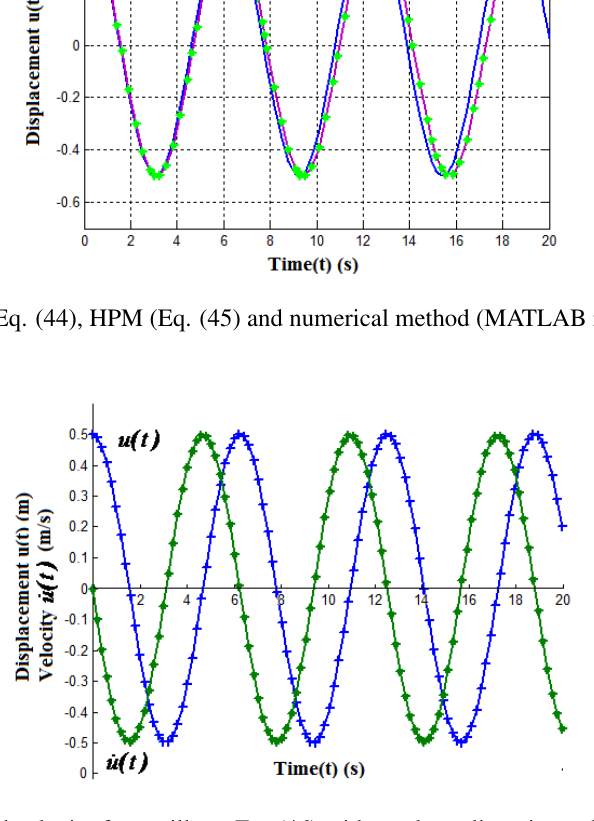
Fig. 6 Plot of displacement and velocity for oscillator Eq. (46) with weak nonlinearity and small amplitude oscillations l = 0 . 5 , ς = 0 . 2